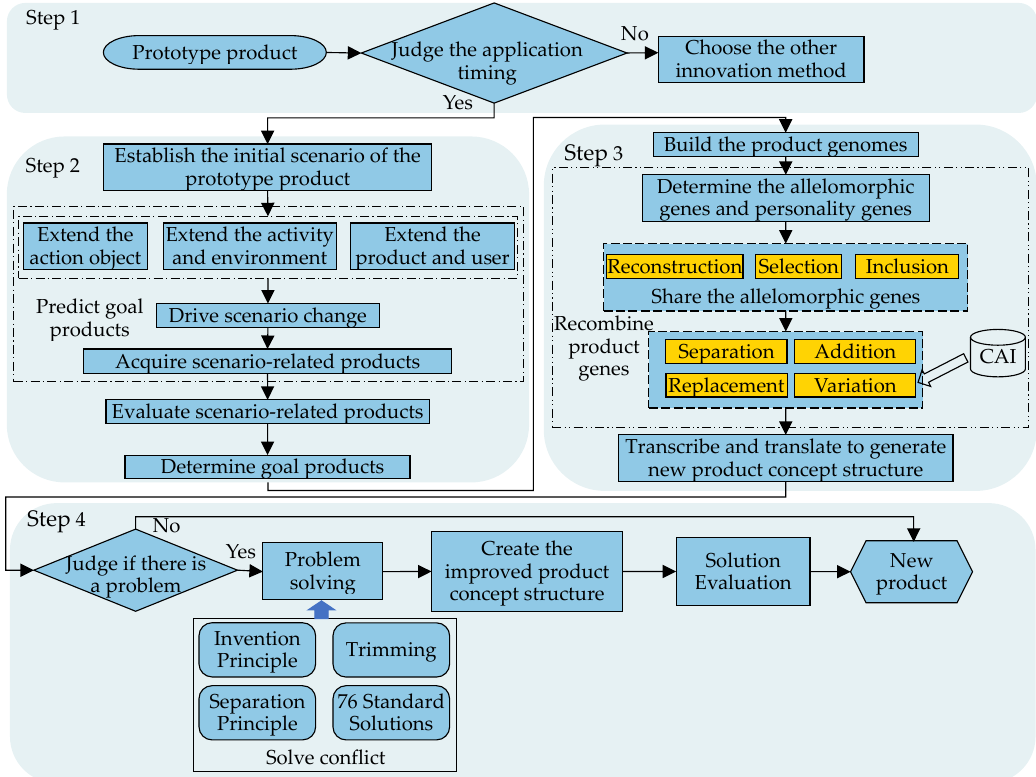
Figure 14. Process model of product functional hybridization design.